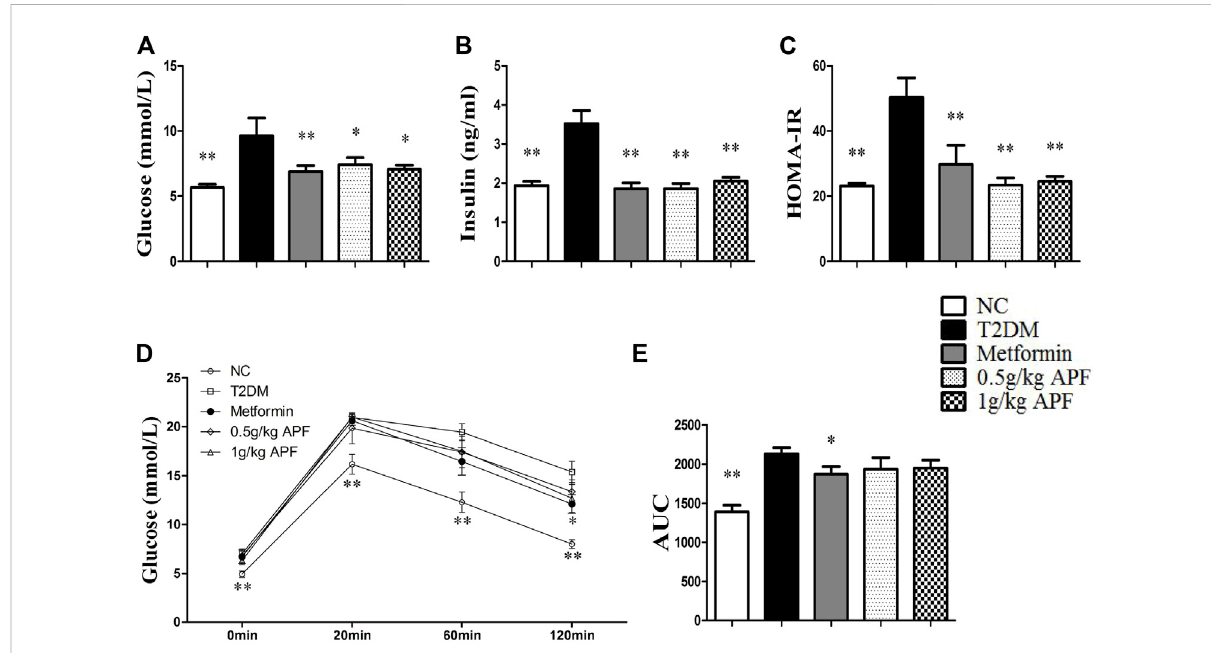
FIGURE 1 Effects of APF on insulin resistance in T2DM mice. Fasting plasma glucose (A) , insulin (B) , homeostatic model assessment of insulin resistance (C) ,plasmaglucosekinetics (D) andareaunderthecurveofkineticspro fi les (E) after2 g/kgoralglucoseadministrationofnormalcontrol(whitebars), type 2 diabetes group (black bars), metformin group (gray bars), 0.5 g/kg APF group (spot bars) and 1 g/kg APF group (grid bars) after treatment with APF 10 weeks. Values are means ± SEMs, n = 8 – 10 per group. * p < 0.05, ** p < 0.01 versus type 2 diabetes